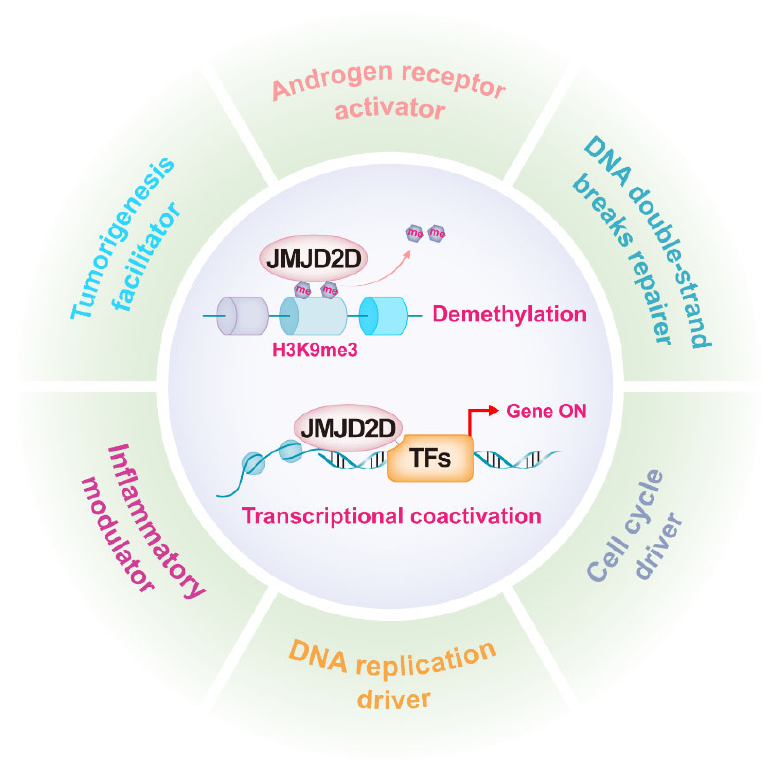
Figure 2. JMJD2D is a multifunctional epigenetic regulator. JMJD2D can promote gene transcription by antagonizing H3K9 methylation and cooperating with multiple transcription factors. JMJD2D has a variety of biological functions, including AR activation, DNA damage repair, DNA replication, cell cycle regulation, inflammation modulation, and tumorigenesis